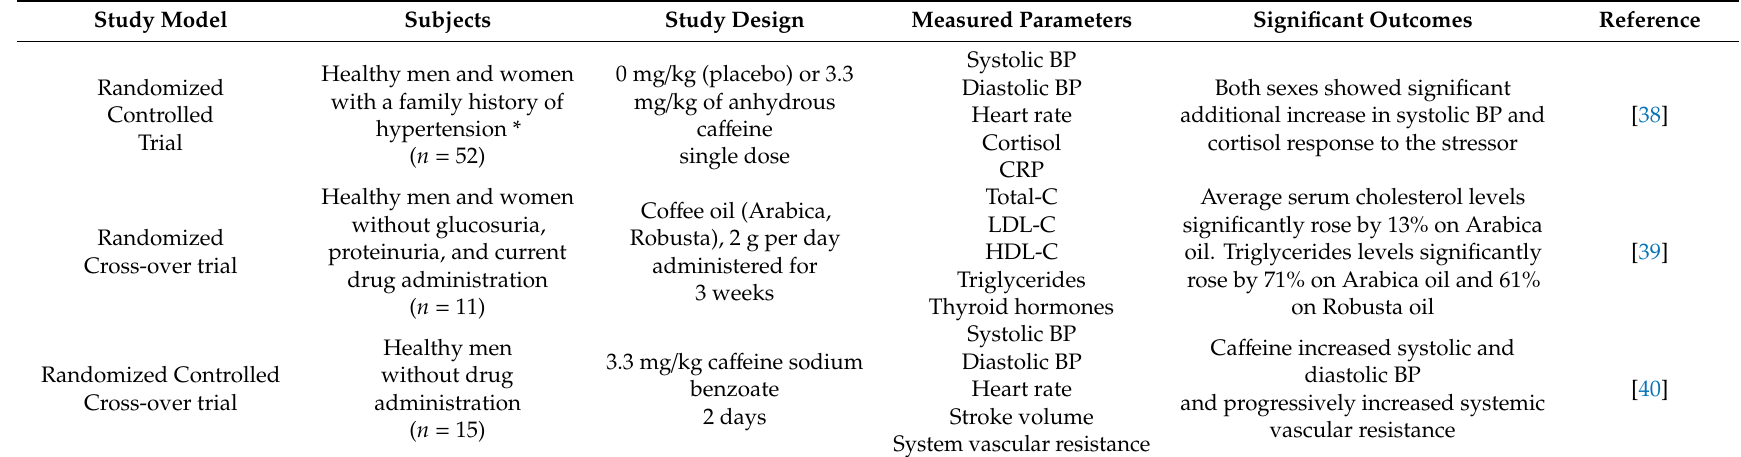
Table 2. Major parameters, clinical characteristics, and outcomes from random controlled trials investigating the influence of co ff ee consumption on cardiovascular disease (CVD) and risk factors reviewed in this